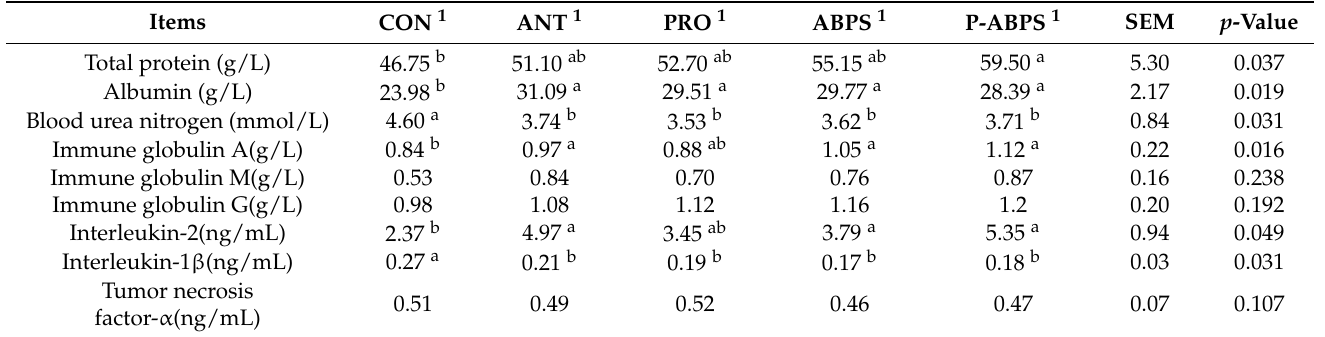
Table 4. Effects of probiotics and Achyranthes bidentata polysaccharides on serum biochemical and immune indexes, and cytokines of